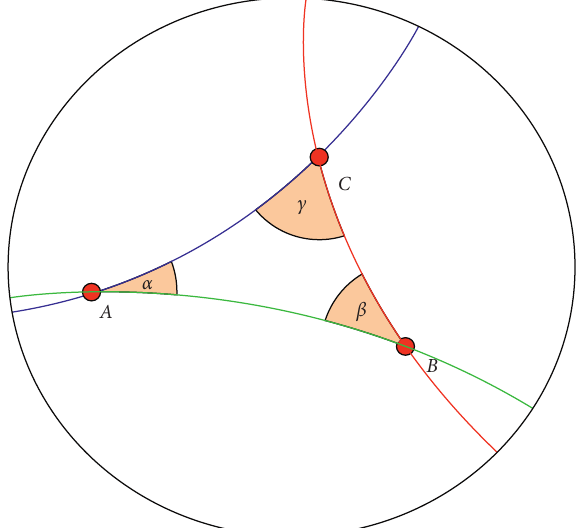
Figure 2: A gyrotriangle (hyperbolic triangle) in the complex unit disc D